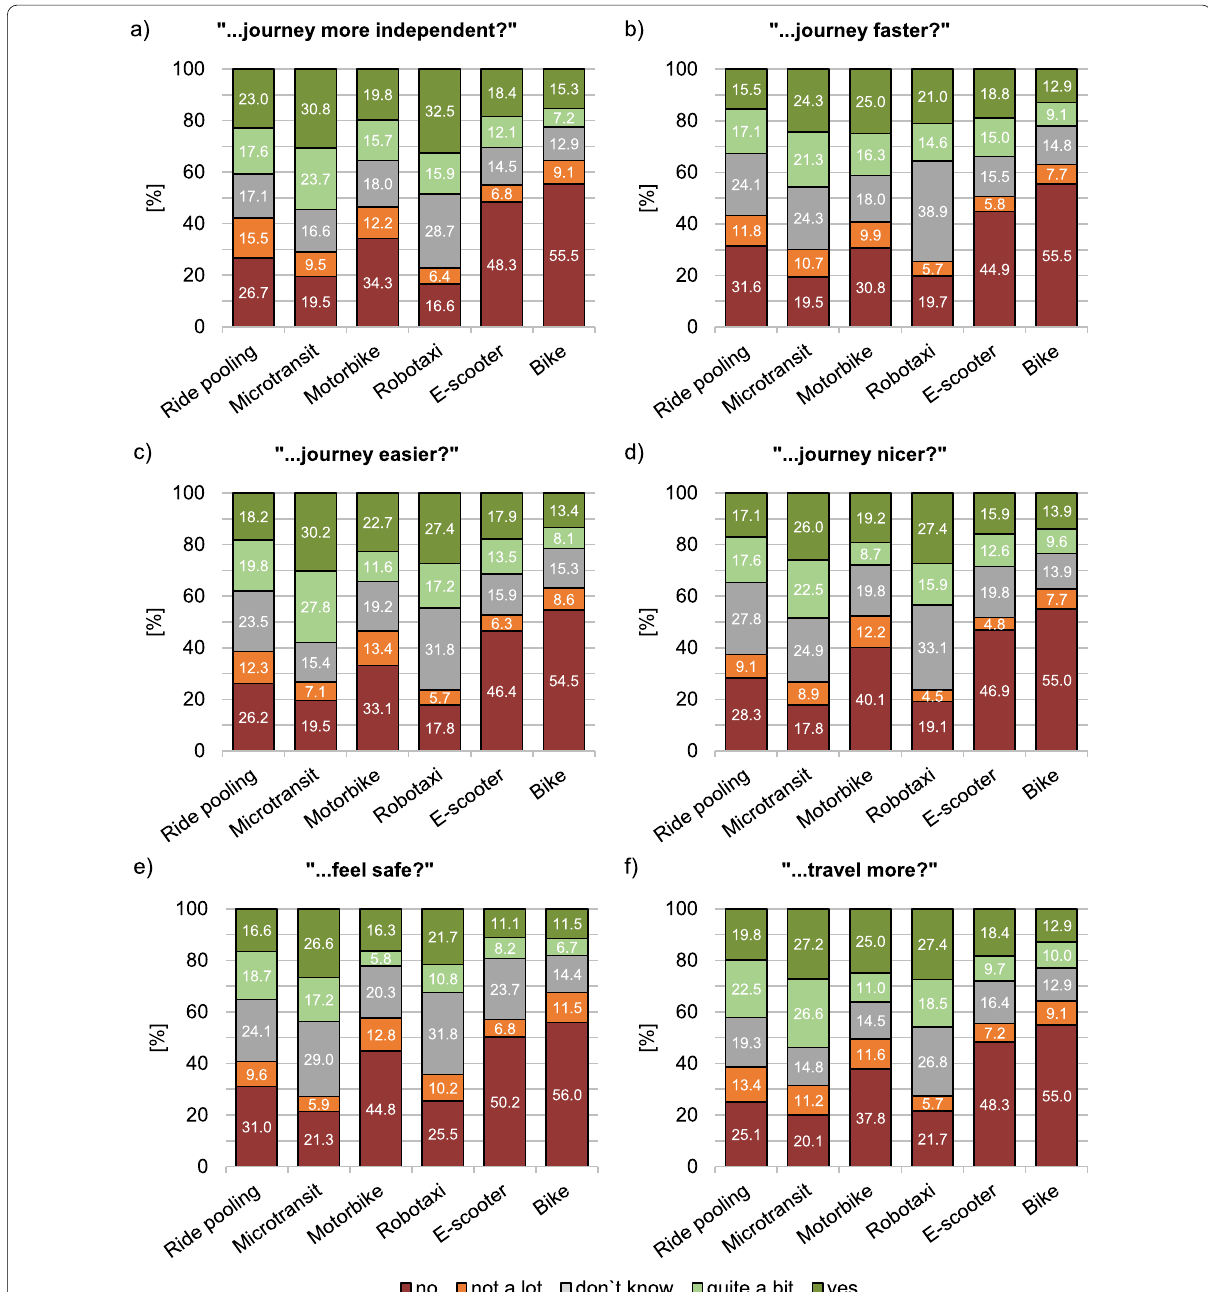
Fig. 2 Assessment of journey quality across disabilities along the travel-related dimensions a autonomy, b travel time, c convenience, d comfort, e safety, and f motivation to travel; note: the size of subsamples differed between the mobility services; ride pooling: n motorbike taxi: n 172, robotaxi: n 157, e-scooter sharing: n 207, bike sharing: n = = = =